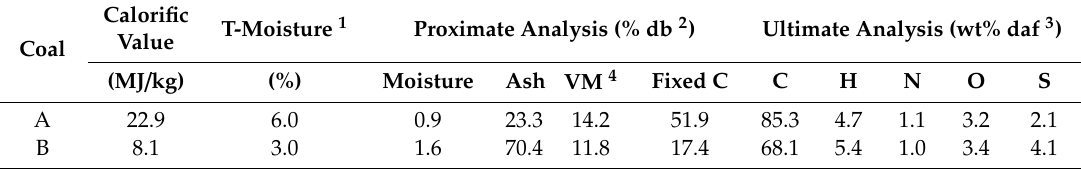
Table 1. Coal analysis results for coal bio-briquettes (CBB)